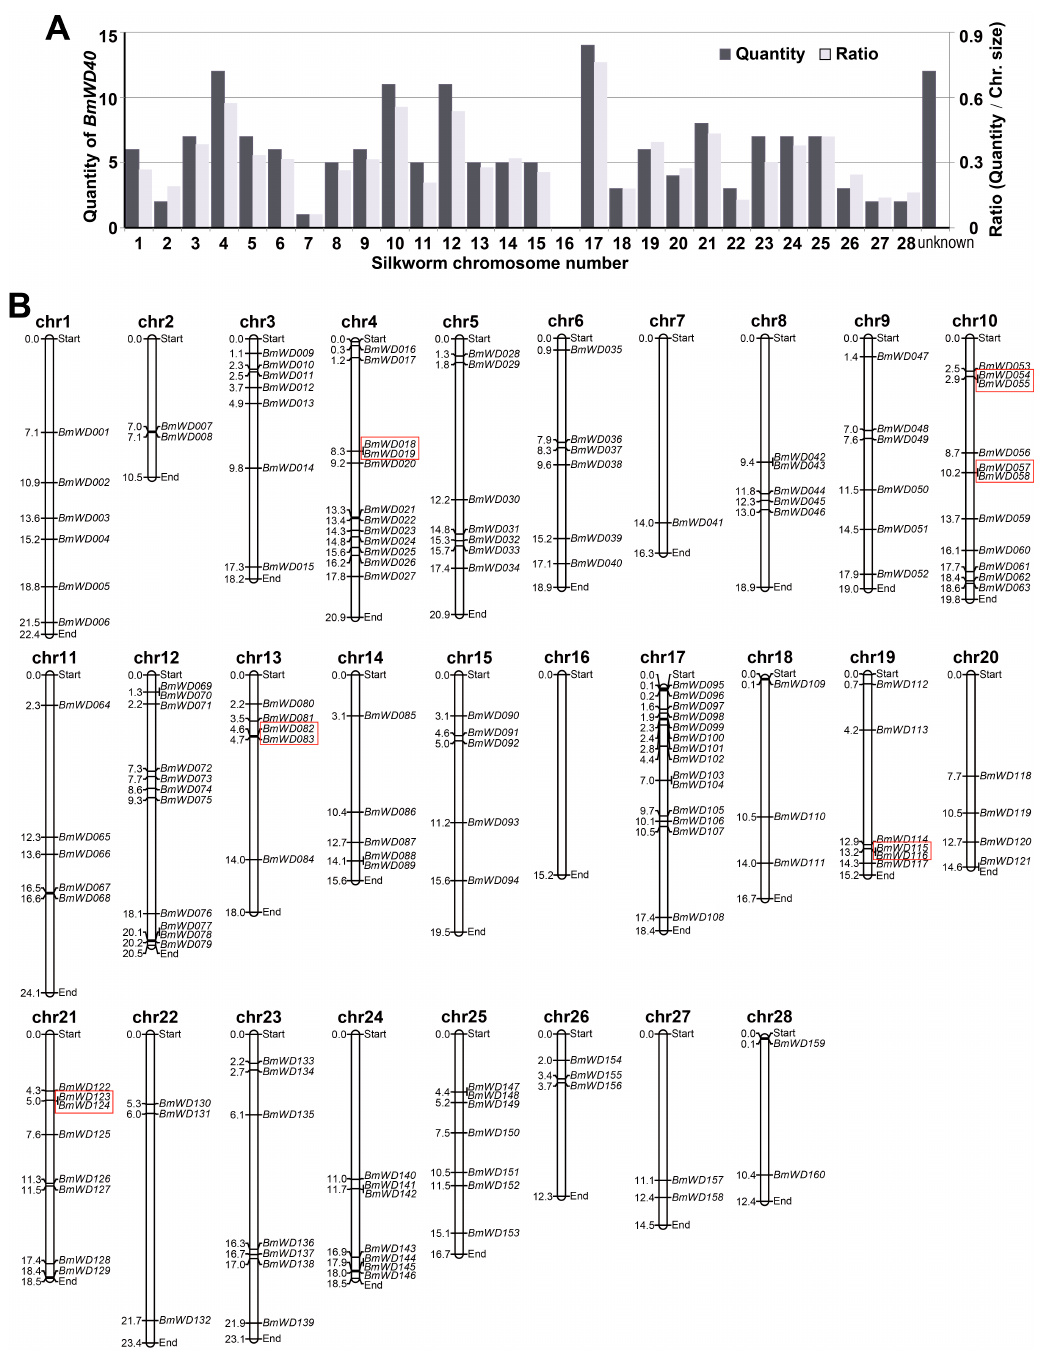
Figure 2. Distribution of the BmWD40 genes on chromosomes. ( A ) Number of BmWD40s on each silkworm chromosome and the ratio of gene number to chromosome size to show the distribution abundance; ( B ) “ BmWD40s distribution map” on silkworm chromosomes. Tandem duplicated genes are marked by red boxes. The chr represents chromosome. Chromosomal distances are given in Mb (Mega base).